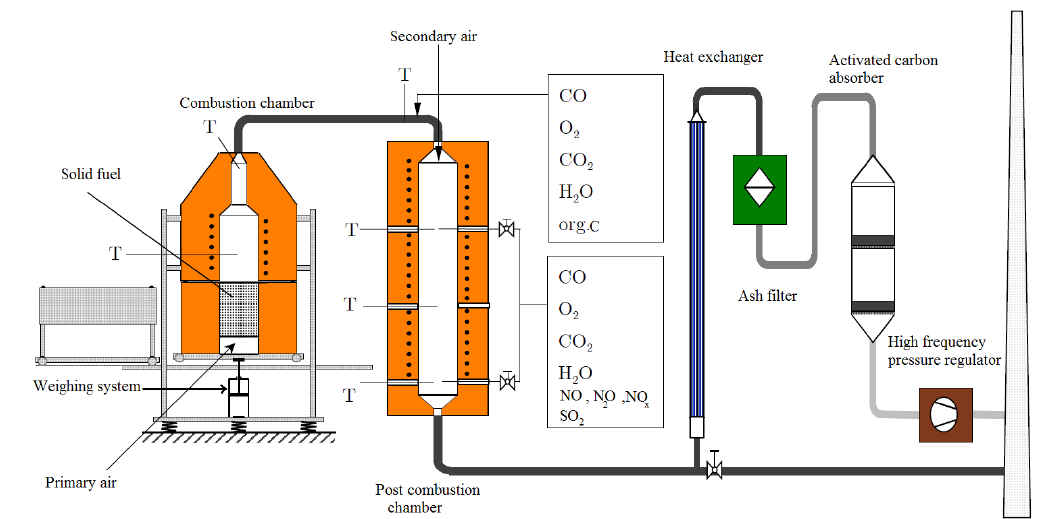
Figure 1. Sketch of the counter-current fixed bed reactor (KLEAA) facility at ITC, Karlsruhe, Germany. The fixed bed has a height, h, of 250 mm and a diameter, d, of 230 mm. It is equipped with thirteen K-type thermocouples which are arranged in 20 mm intervals along the chamber’s axis to measure the central bed temperature as it is shown in Figure